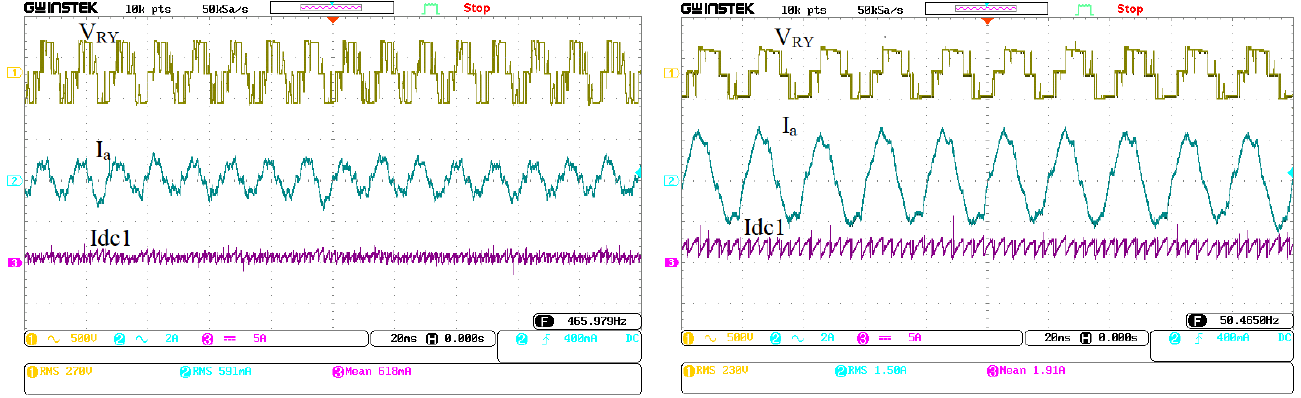
Figure 10. Experimental voltage and current waveform at a modulation index of 0.9.